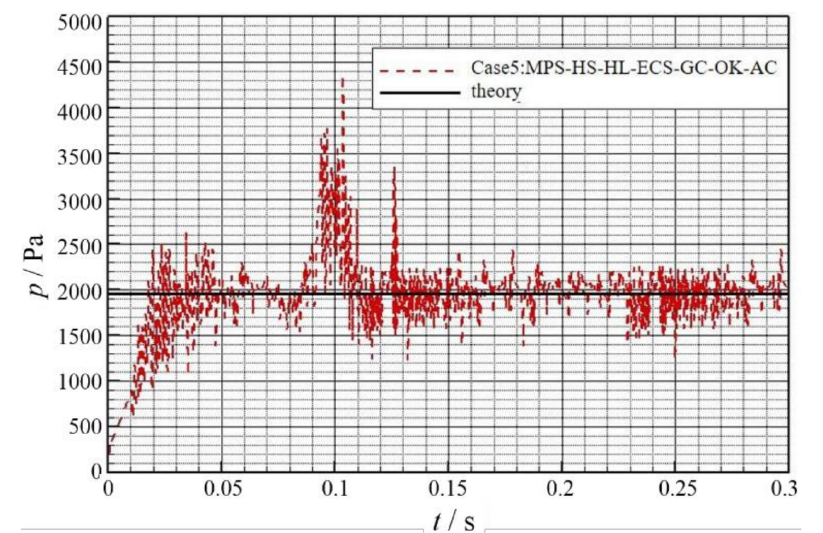
Figure 6. Time variation of pressure at the measuring